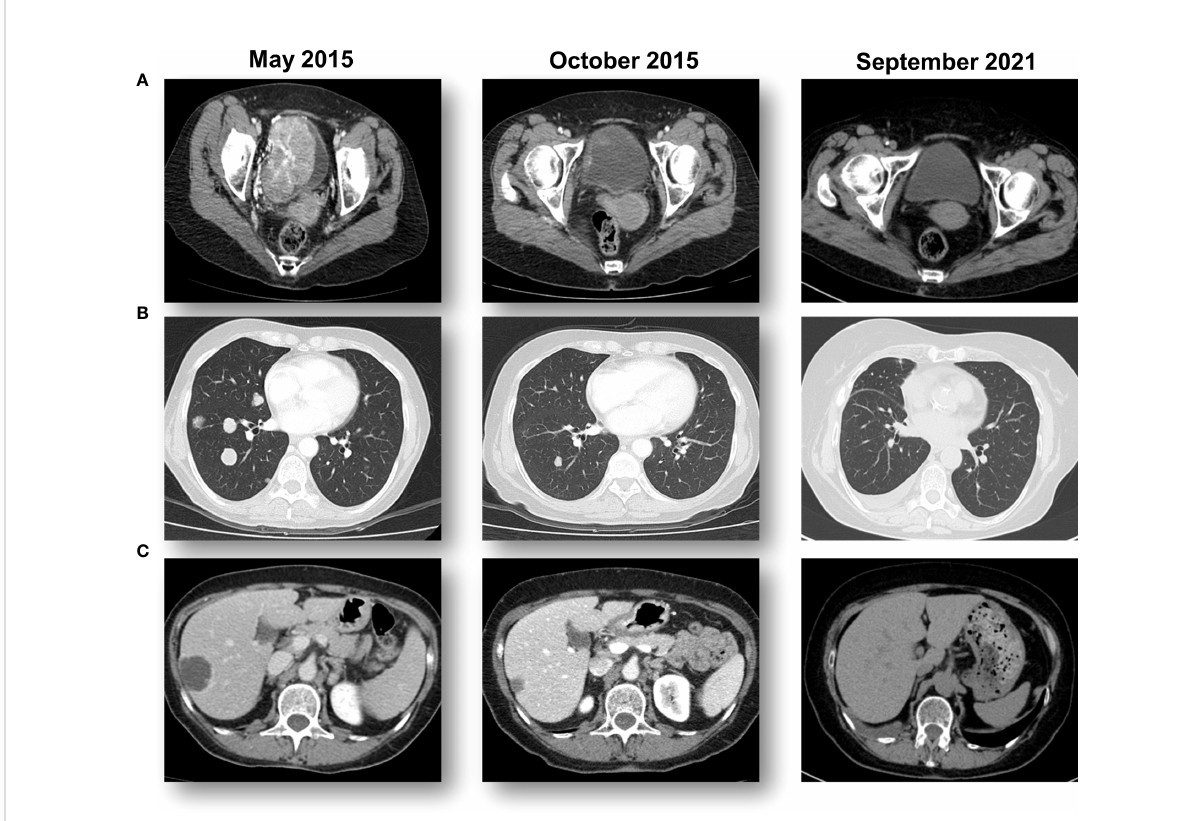
FIGURE 1 Sequential CT scans showing a response to pemprolizumab. (A) A large bladder tumor that was biopsied prior to starting pembrolizumab immunotherapy with a complete response in the bladder. (B) Multiple lung metastases from bladder cancer that obtained a complete response with pembrolizumab immunotherapy. (C) Multiple hepatic metastases from bladder cancer that obtained a complete response with pembrolizumab